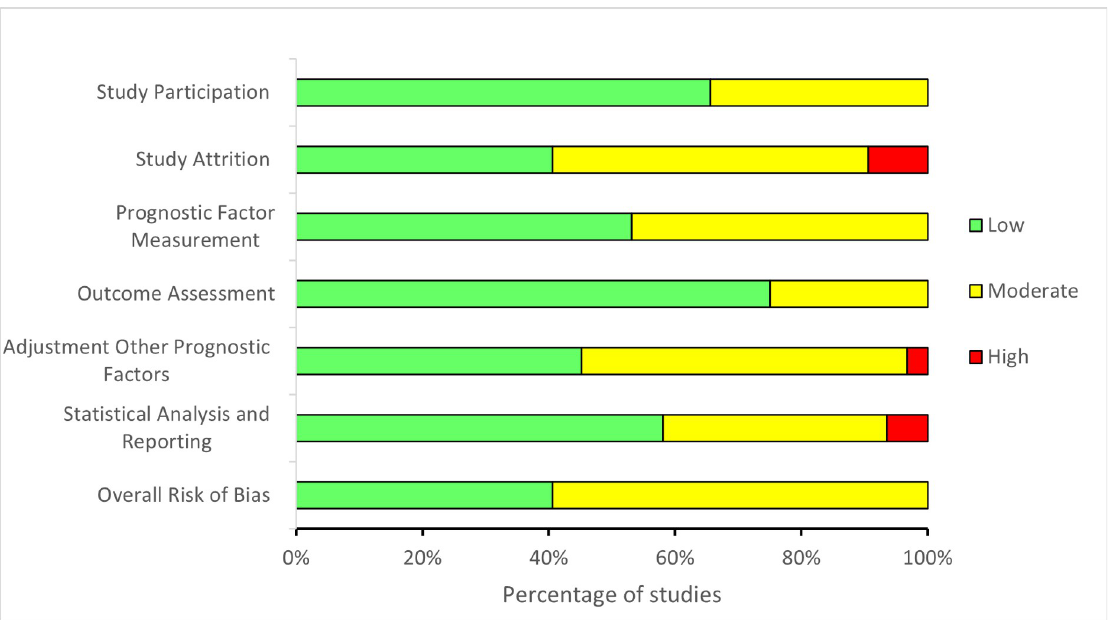
Fig 2. Summary of risk of bias assessment using Quality in Prognostic Studies (QUIPS) according to the six domains of the 32 included studies.